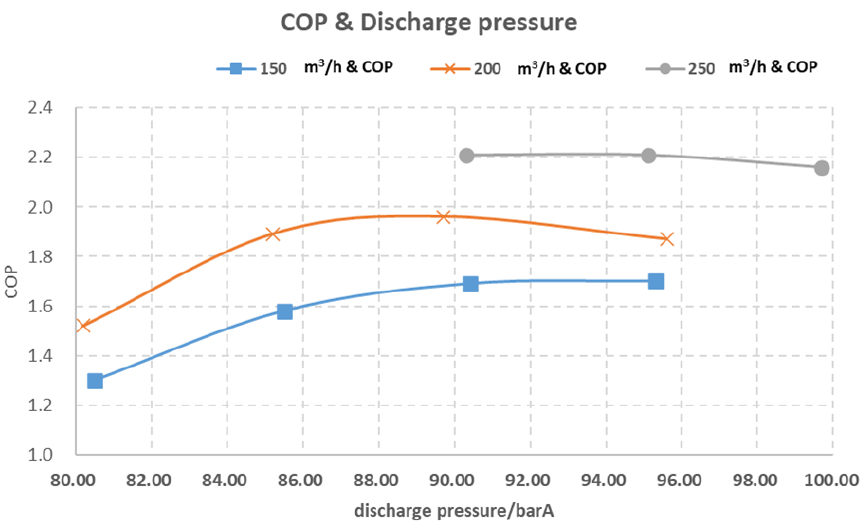
Figure 9. COP along with discharge pressures in different HVAC air flows.